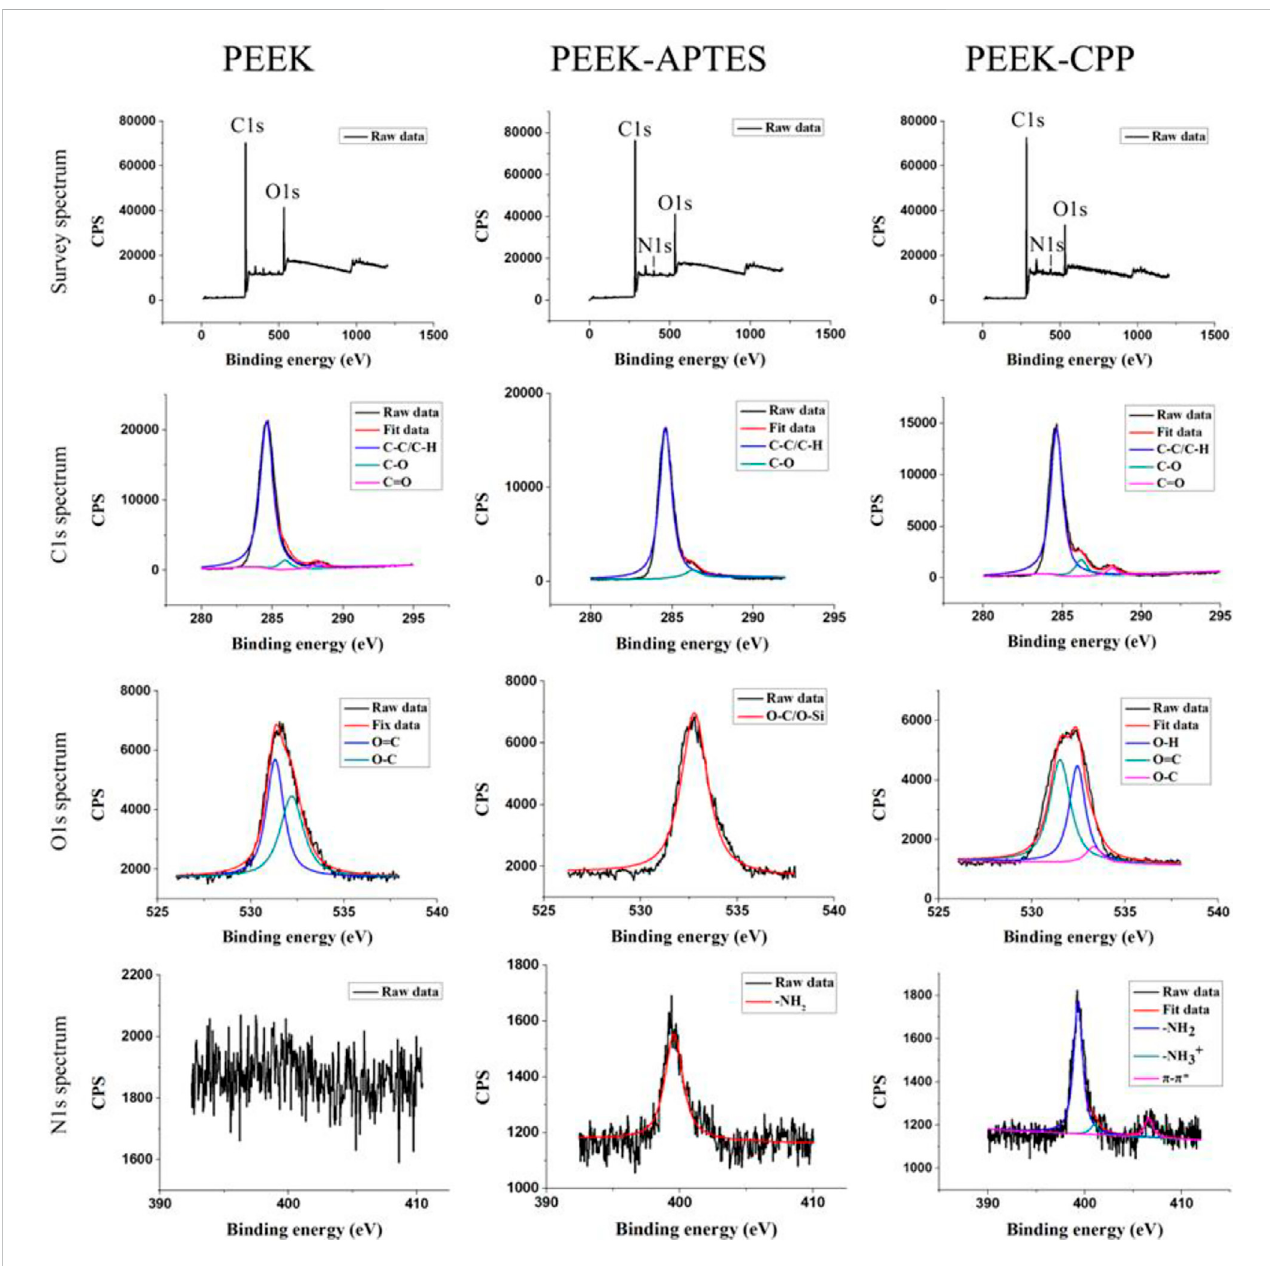
XPS survey spectra and high-resolution spectrum of C1s, O1s, and